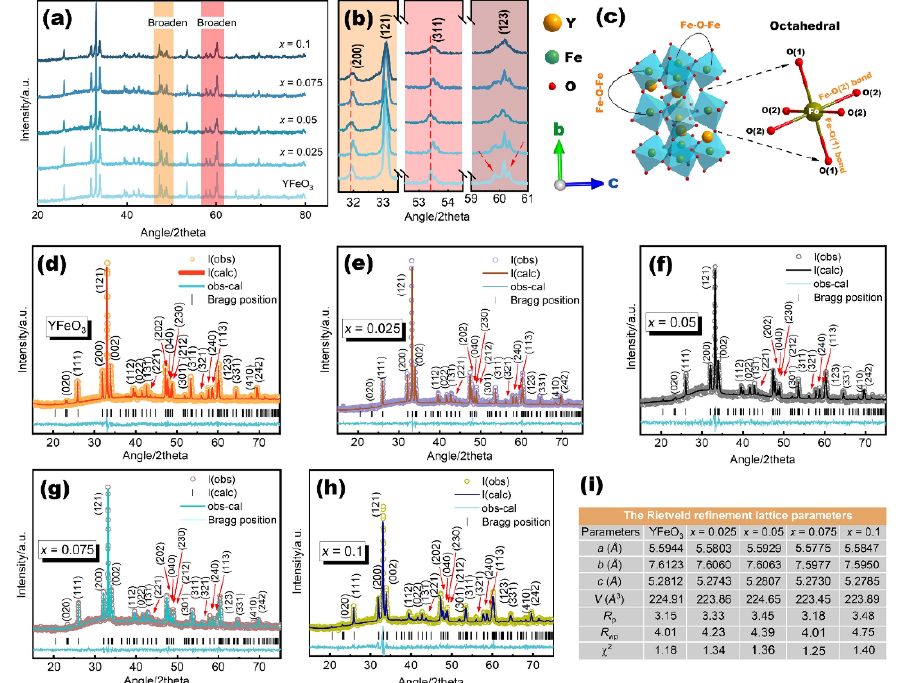
Figure 1. ( a ) XRD patterns of YFM x O (0 ≤ x ≤ 0.1); ( b ) enlargement patterns of the main peaks; ( c ) crystal structure of the YFM x O ( x = 0.1); ( d – h ) Rietveld refinement profile of YFM x O; ( i ) lattice parameters of YFM x O.